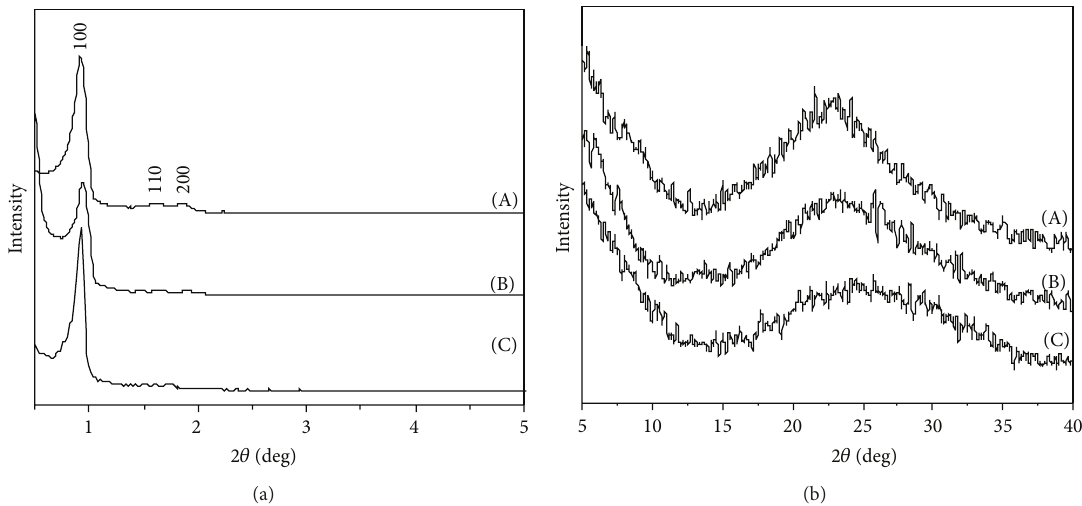
Figure 1: (a) Small-angle XRD patterns of the pure SBA-15 (A), TiO 2 -SBA-15 (B), and N-TiO 2 -SBA-15 (C); (b) Large-angle XRD patterns of the pure SBA-15 (A), TiO 2 -SBA-15 (B), and N-TiO 2 -SBA-15 (C).